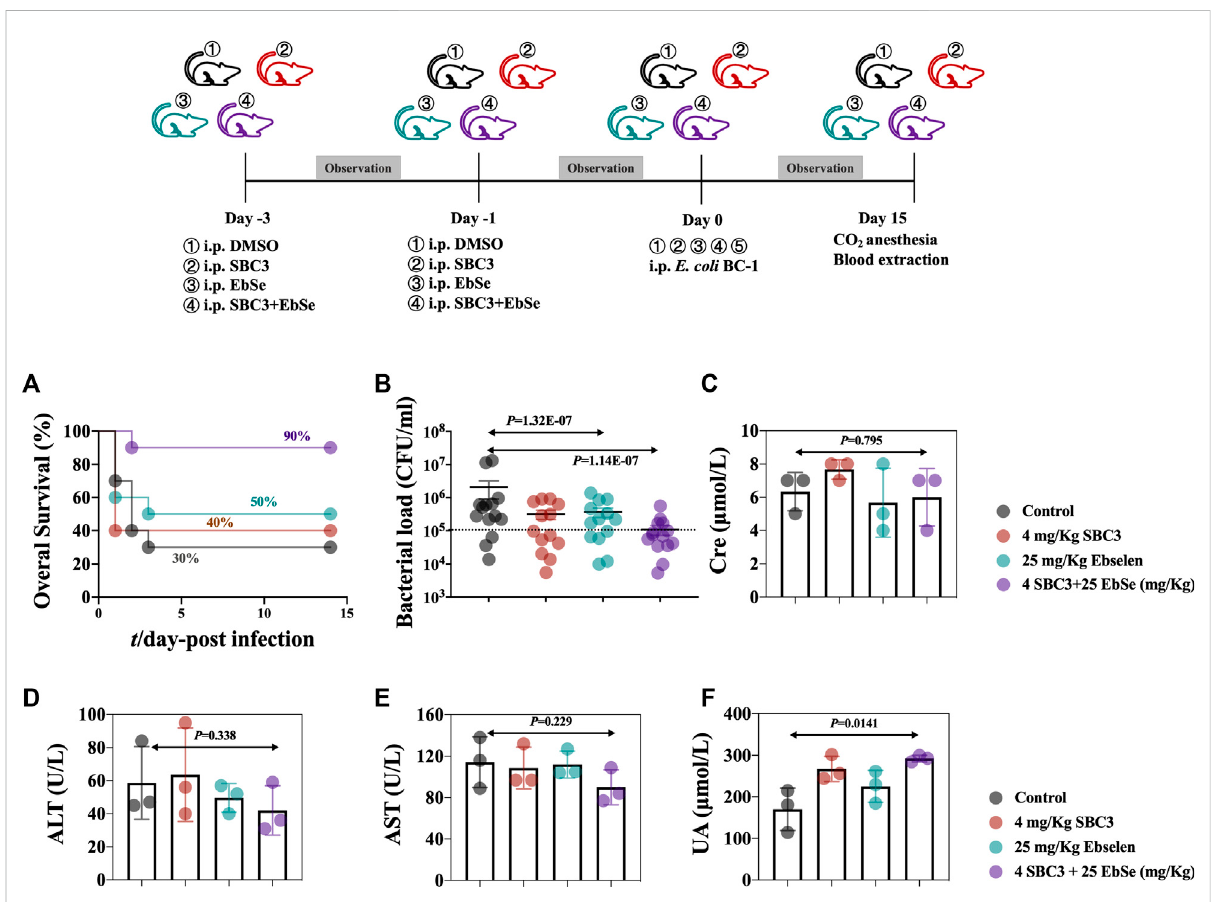
Therapeutic ef fi cacy of SBC3 and Ebselen in treating E. coli BC1-induced peritonitis. (A) MDR BC1 was cultured overnight, and mice (n = 15) were injected i.p. with DMSO, 2 mg/kg SBC3, 25 mg/kg Ebselen, 2 mg/kg SBC3 and 25 mg/kg Ebselen in combination on the day 1- and 3- before infection. On day 0, mice infected with 100 μ L 2 × 10 8 CFU/ml to construct an acute peritonitis model. Overall survival was observed. Data are presented by log-rank (Mantel-Cox) test, p < 0.05 constitutes statistical signi fi cance. (B) MDR BC1 was cultured overnight, and mice (n = 10) were injected i.p. with DMSO, 2 mg/kg SBC3, 25 mg/kg Ebselen, 2 mg/kg SBC3 and 25 mg/kg Ebselen in combination on the day 1- and 3- before infection. On day 0, mice infected with 100 μ L 2 × 10 7 CFU/ml to construct a mild peritonitis model. The bacterial load was calculated by counting the colonies. Data are presented by chi-square test, p < 0.05 constitutes statistical signi fi cance. To evaluate the effects of SBC3 in combination with Ebselen on the kidney and liver function of mice, the sera of mice were collected 14 days post-infection, and contents of CRE (C) , ALT (D) , AST (E) , and UA (F) were measured. Data are presented by Student ’ s t test, p < 0.05 constitutes statistical signi fi